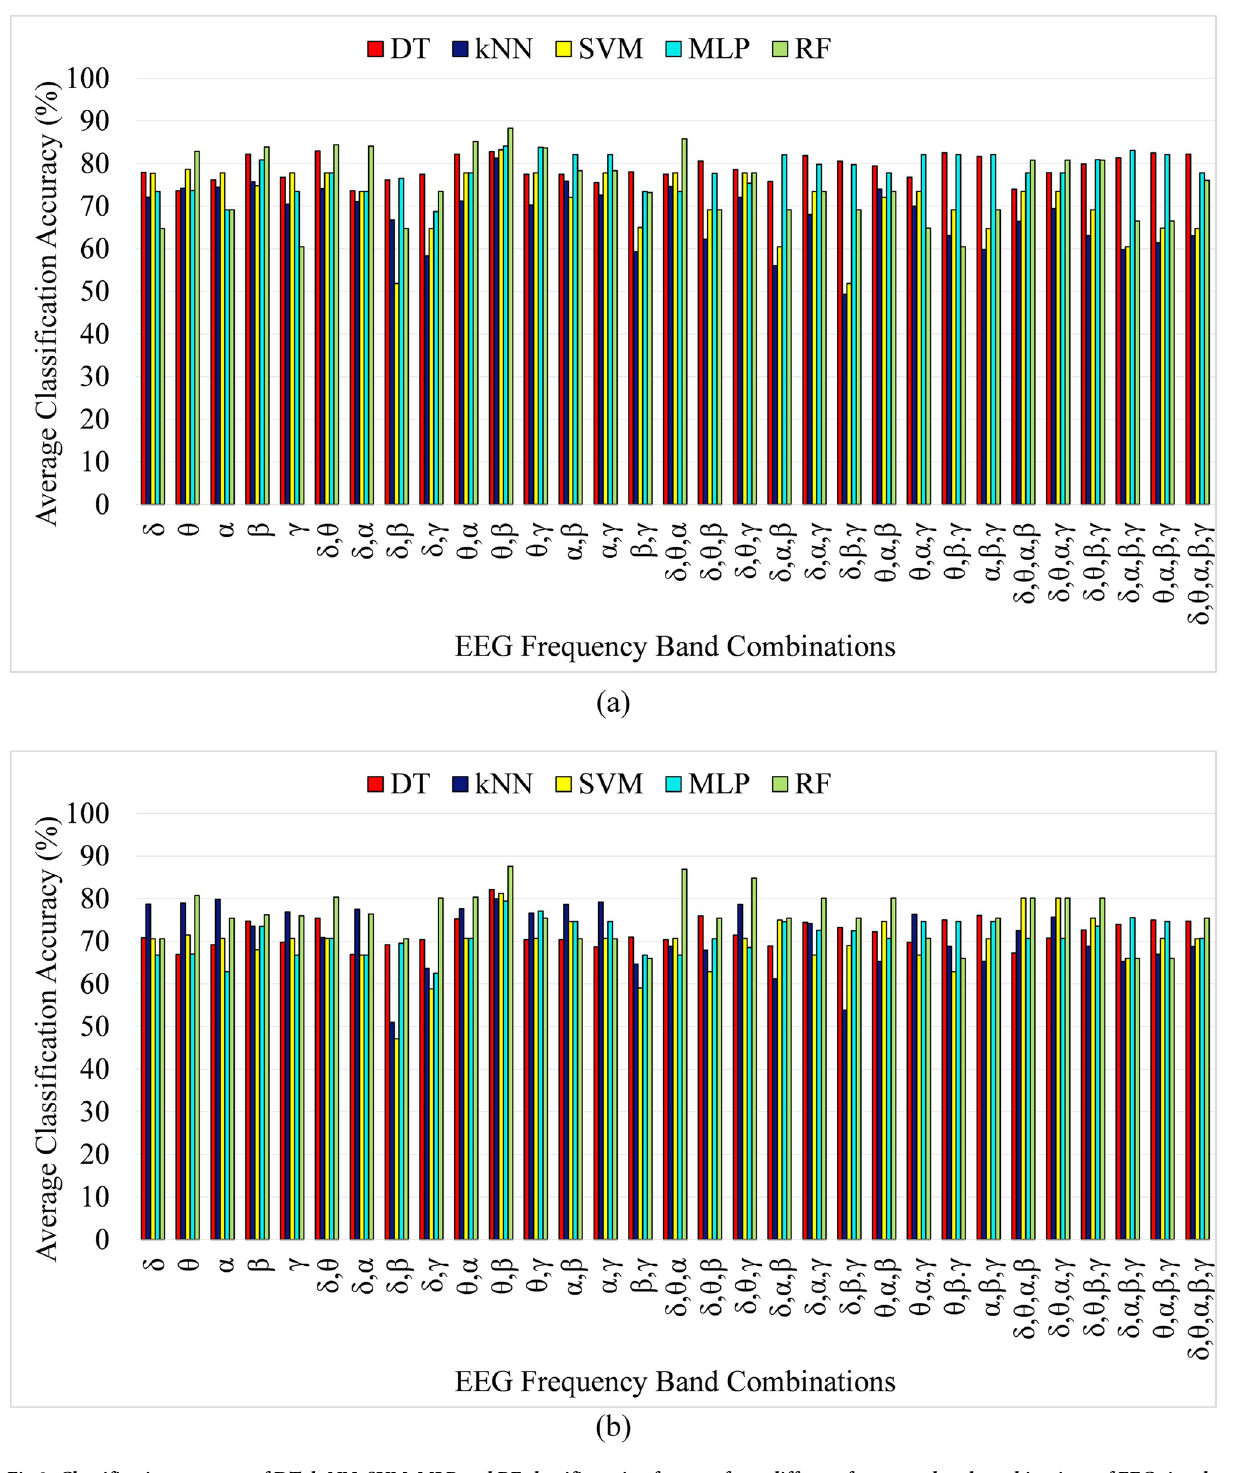
Fig 8. Classification accuracy of DT, k-NN, SVM, MLP and RF classifier using features from different frequency band combinations of EEG signal using HAM-A based labeling for (a) Two-levels (b) Four-levels anxiety classification.